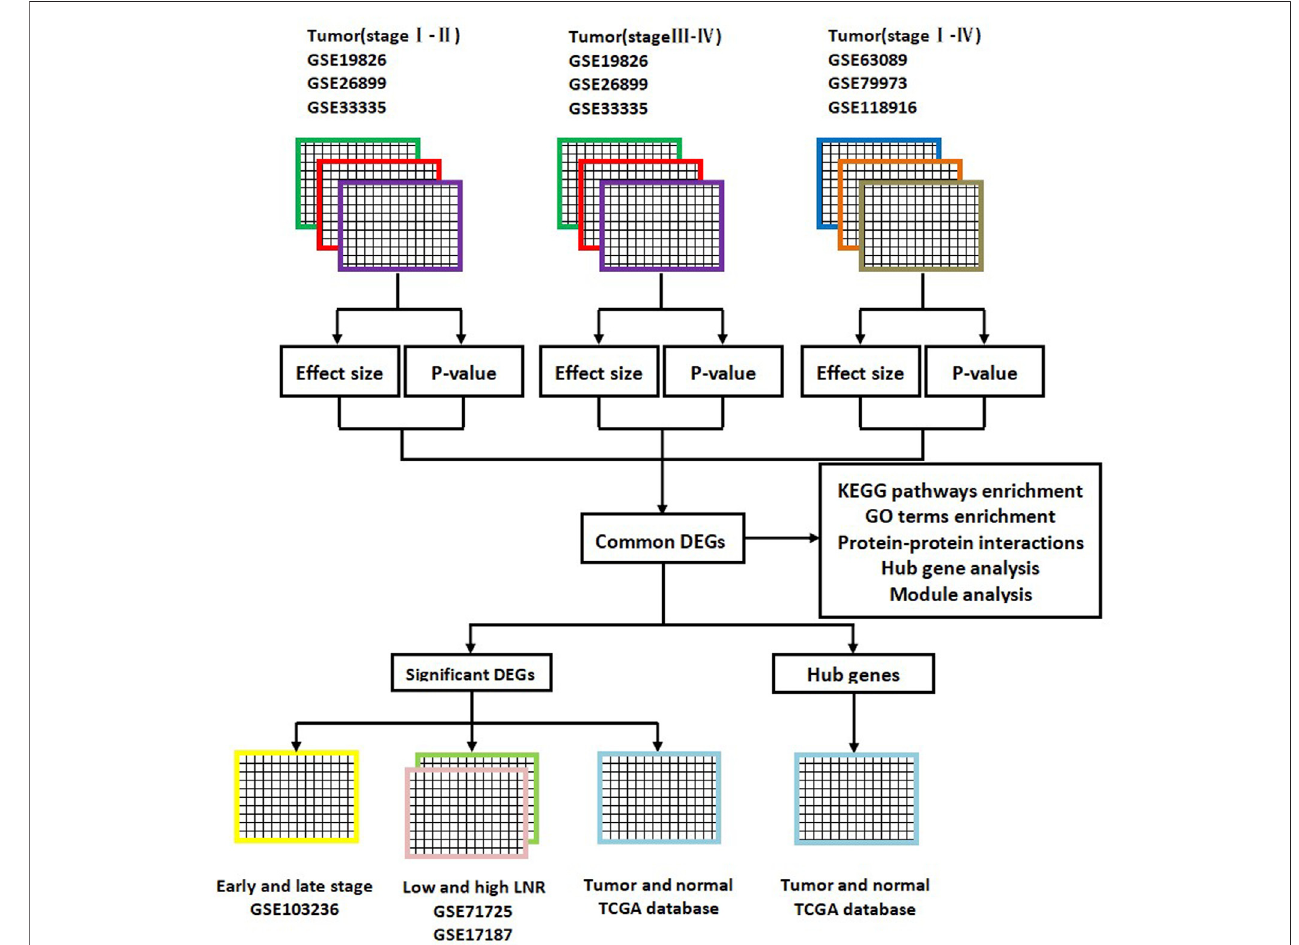
FIGURE 1 | Flow diagram of this bioinformatics and meta-analysis. DEGs, differentially expressed genes; KEGG, Kyoto Encyclopedia of Genes; GO, gene ontology; LNR, lymph node ratio; TCGA, The Cancer Genome Atlas.